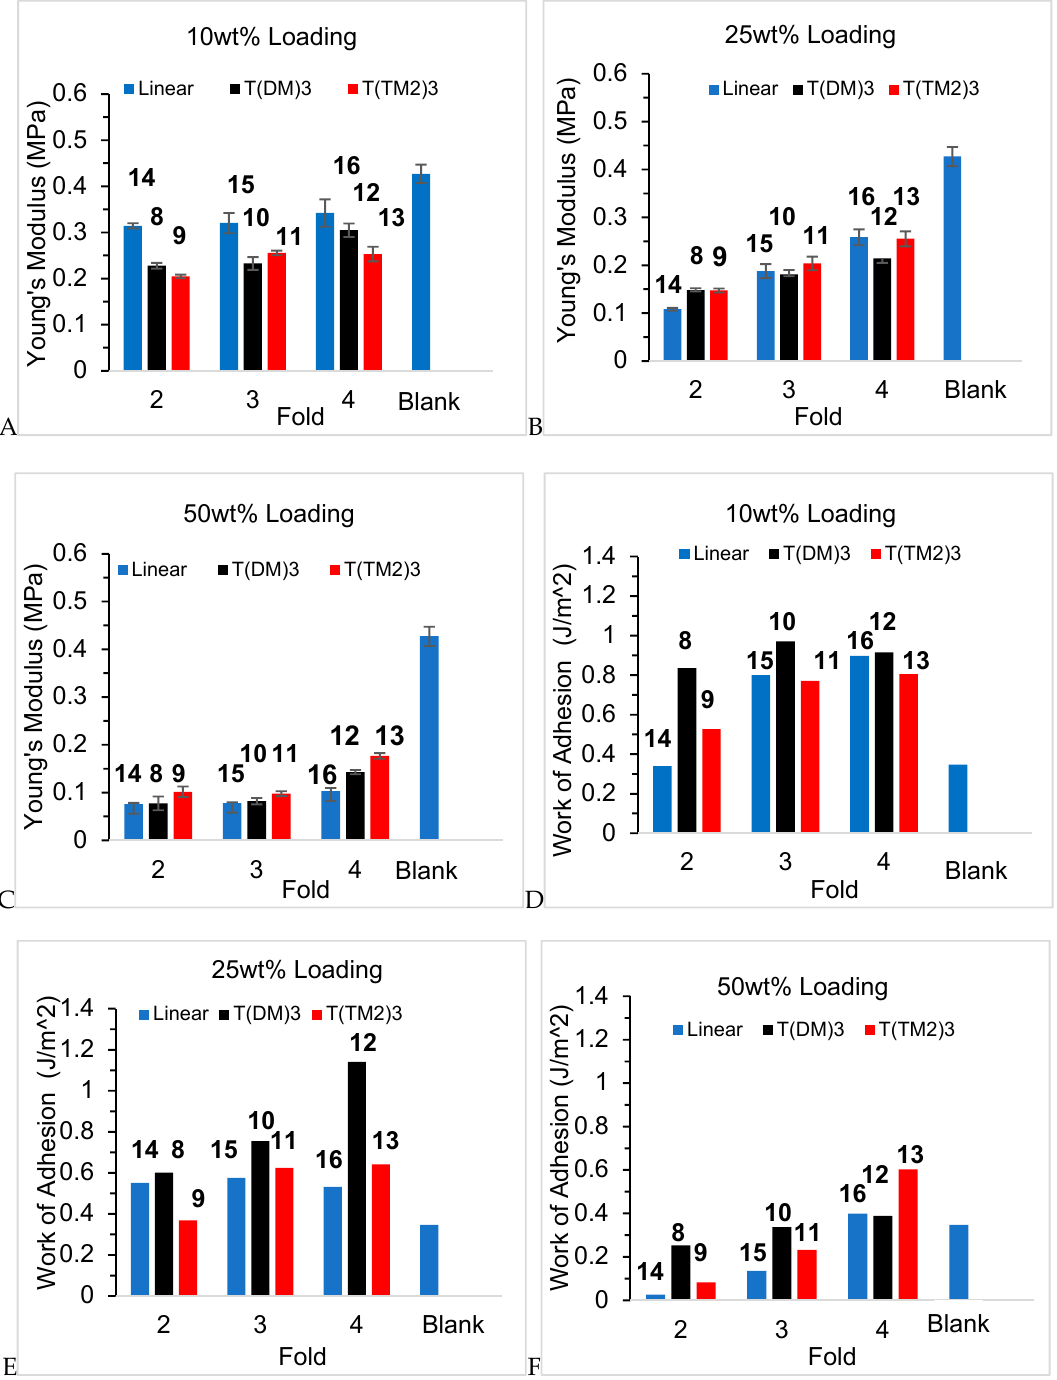
Figure 5. ( A – C ) Young’s modulus of silicone oils 8–16 at three weight fractions (10, 25, 50%) in the control silicone elastomer. ( D – F ) Adhesion work as a function of loading (10, 25, 50%) of oil in the elastomer. Table 1. Work of adhesion of oil filled elastomers.